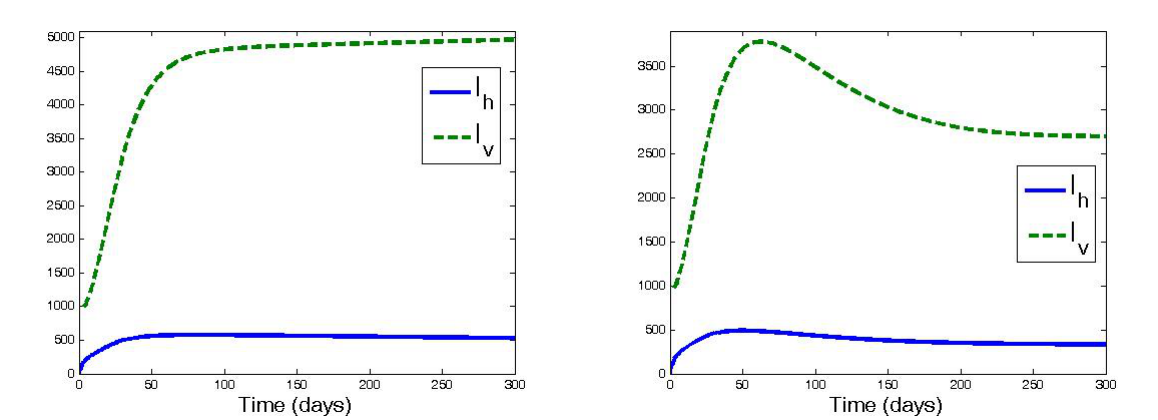
Figure 1. Panel A: Dynamics of infectious humans I by Model M (9). The parameter values are given in Table 1, except that β = 0 . 09 and η = 0 . 0524 . Initial data are ( N